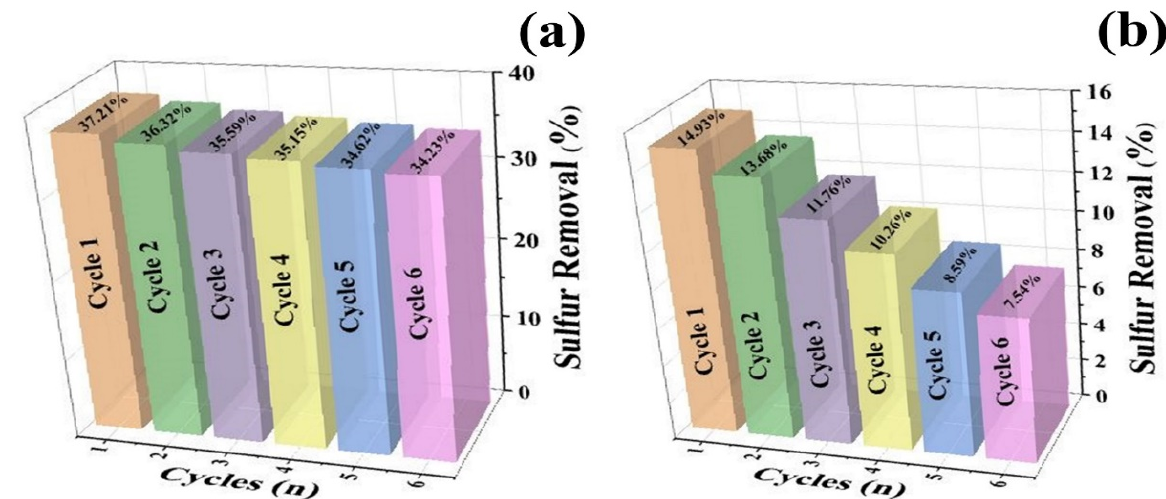
Figure 7. Recyclability of the micro-spherical V 2 O 5 photocatalyst over desulfurization of ( a ) diesel oil blend and ( b ) straight-run diesel.